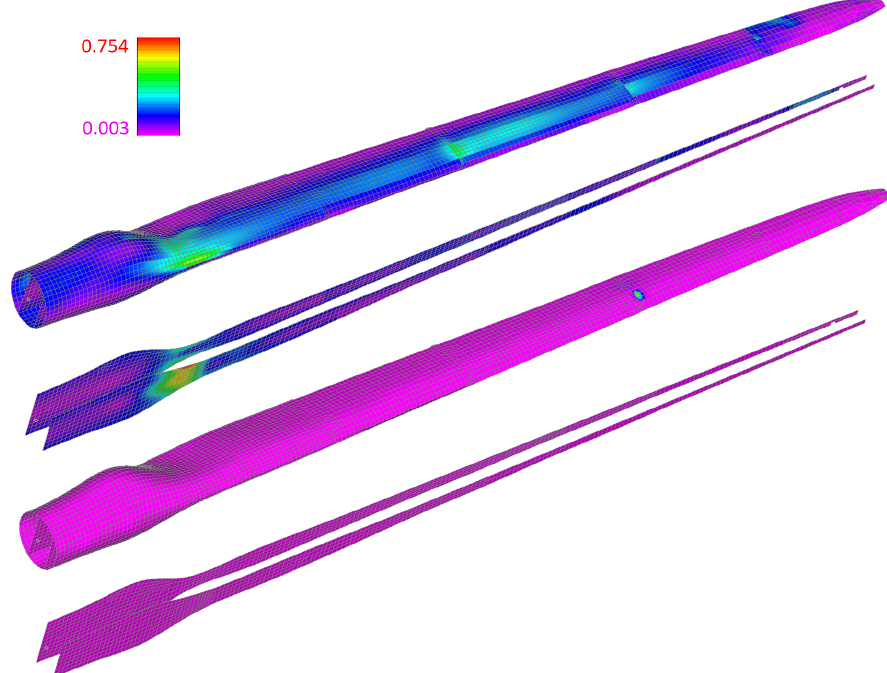
Figure 11. FEA fiber failure index and buckling eigenvector results for MOSOP1 solution